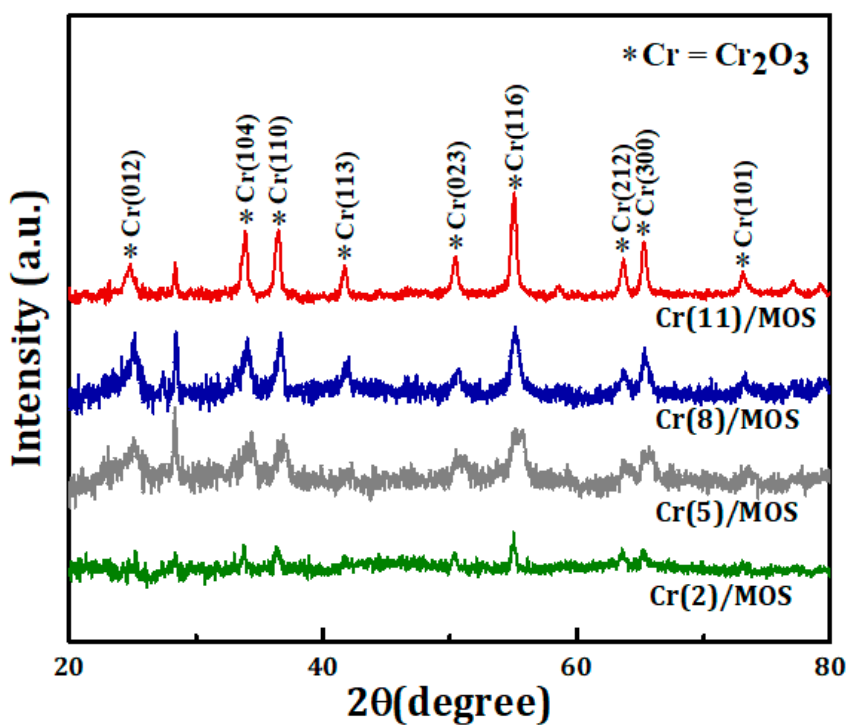
Figure 2. XRD patterns of Cr(x)/MOS catalysts prepared with varying Cr loading (*Cr= Cr 2 O 3 ). In order to establish more details on the surface topography of the prepared samples and to assess the dispersion of the Cr species over Cr(x)/MOS catalysts, TEM, SEM imaging, and EDX elemental mapping were obtained on MOS, Cr(2)/MOS, Cr(8)/MOS, and Cr(11)/MOS catalysts; the images are presented in Figure 3. TEM images of bare MOS (Figure 3a*) show the formation of the mesoporous organo-silica matrix. After loading of 2 wt.% of Cr (Figure 3b*), the Cr oxides had rod and cubic shapes, and their widths were in the range of 15–35 nm with good distribution onto the mesoporous organo-silica matrix. Increasing the Cr content to 8 wt.% (Figure 3c*) resulted in the formation of cubic Cr oxide nanoparticles with growth of their sizes to 50–100 nm. The state of distribution of the Cr oxide nanoparticles onto the organo-silica matrix was quite acceptable. However, increasing the loading content of Cr oxide nanoparticles to 11 wt.% (Figure 3d*) caused the formation of a mixture of rod and cubic nanoparticles with size range of 150–300 nm and poor distribution character onto the mesoporous organo-silica matrix. EDX elemental mapping also was used to investigate more about the state of distribution of CrOx onto the mesoporous organo-silica matrix. It could be clearly observed that CrOx species were well-dispersed on the surface of the mesoporous organo-silica support for all prepared catalysts (Figure 3a–d; CrOx can be seen as golden color dots), and the intensity of golden dots is increasing as the chromium content increased. The Cr(11)/MOS (Figure 3d, golden) catalyst show some agglomeration of Cr species of CrOx, as clearly seen from the larger golden dots, Cr(8)/MOS (Figure 4c, golden) possessed uniform distribution of Cr species at the catalyst surface with fine small particles. Good dispersity and the size of the metal particle are fundamental aspects governing the catalytic performance of metal-supported catalytic